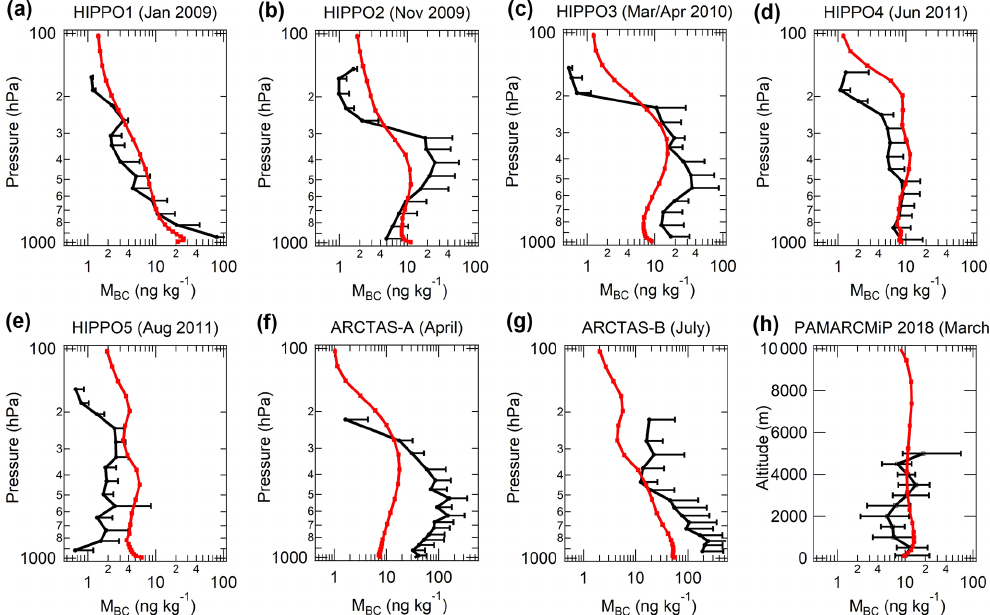
Figure 4. Comparisons between observations (black) and model simulations (red) for BC mass concentration ( M BC ) vertical profiles at high latitudes in the Northern Hemisphere during (a–e) the HIPPO campaigns ( a January 2009, b November 2009, c March–April 2010, d June 2011, and e August 2011), (f–g) the ARCTAS campaigns ( f April 2008 and g July 2008), and the PAMARCMiP campaign in March–April 2018. For the HIPPO campaigns, simulated M BC concentrations are averaged over the region of 60–80 ◦ N, 140–170 ◦ W for the observation year and month. For the other campaigns, simulated M BC concentrations are averaged for 7 years (2009–2015) over the regions of 60–80 ◦ N, 70–165 ◦ W in April for ARCTAS-A; 45–87 ◦ N, 40–135 ◦ W in July for ARCTAS-B; and 78–85 ◦ N, 24 ◦ W–20 ◦ E in March for PAMARCMiP. For the observed M BC , the means and standard deviations are shown against atmospheric pressure for the HIPPO and ARCTAS campaigns, and the medians and 25th–75th percentiles are shown against altitude for the PAMARCMiP campaign.